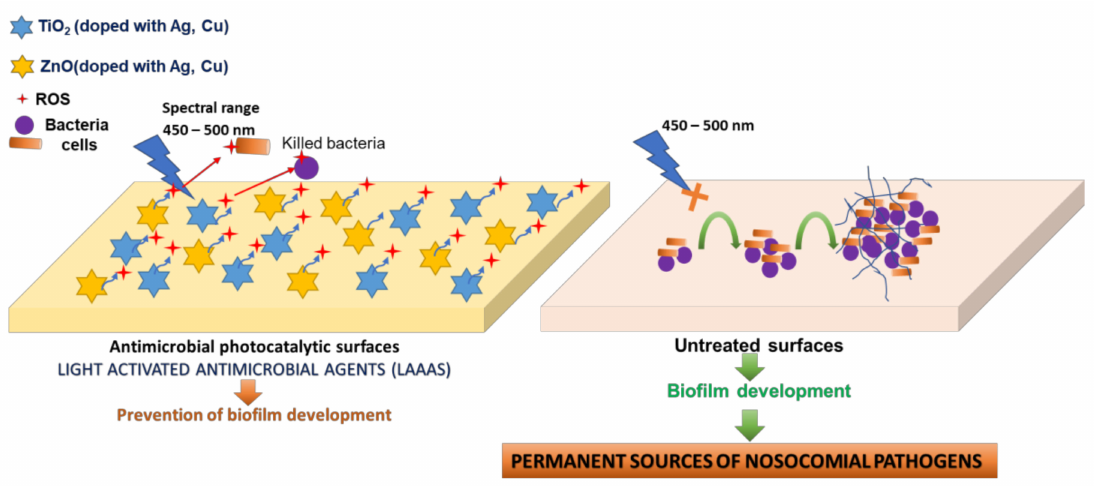
Figure 1. Proposed mechanism for the photocatalytic protection of medical supplies surfaces. The release of ROS molecules during the photoexcitation process prevents the irreversible adherence of the microbial cells to the treated surfaces and the generation of mature biofilms by altering the cell wall structures implicated in the adherence processes (left side of the figure). Instead, on untreated inert surfaces, microbial cells can adhere irreversibly and can generate mature biofilms, responsible for the spread of pathogenic strains, especially those with nosocomial properties (right side of the